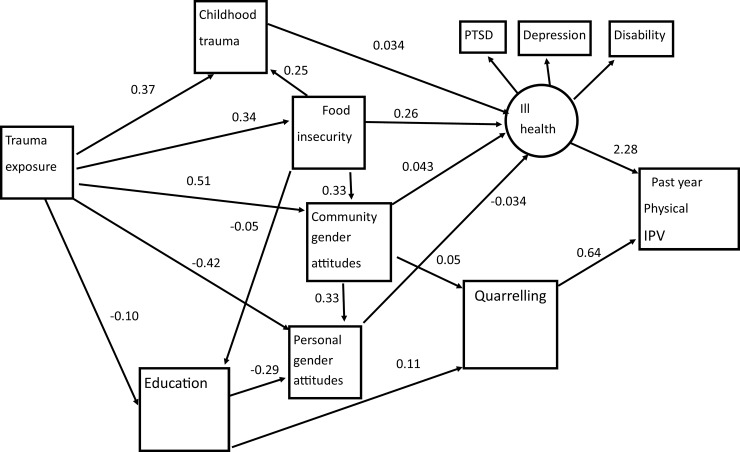
Structural model of factors influencing women's experience of physical intimate partner violence (IPV) in the past year (standardized path coefficients {only statistically significant paths shown}).